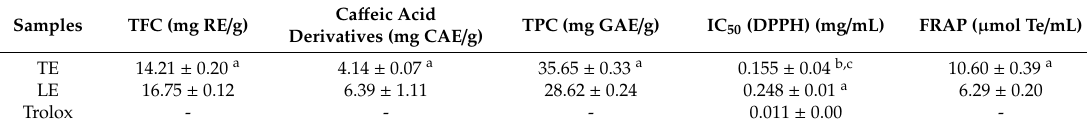
Table 1. Total phenolic contents and antioxidant activity of V . vinifera Fn LE and TE. Samples TFC (mg RE /